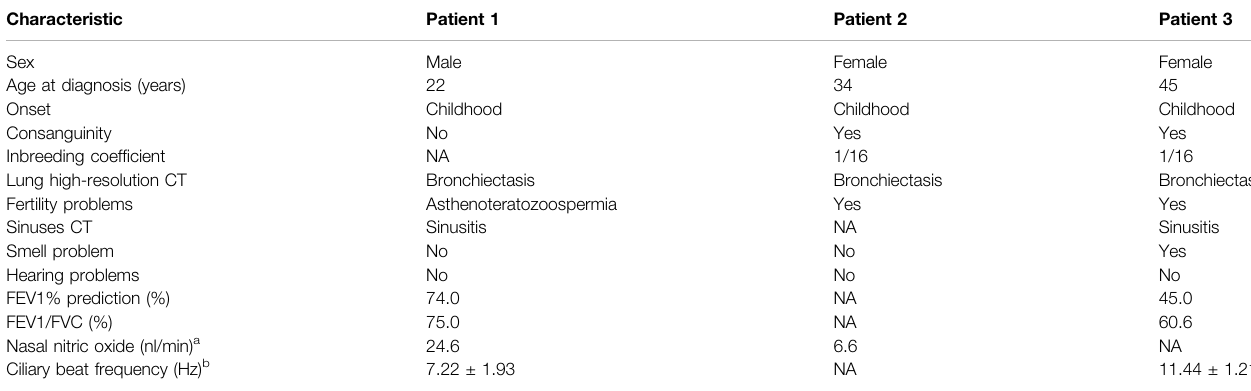
TABLE 1 | Summary of the clinical features of three patients with PCD.